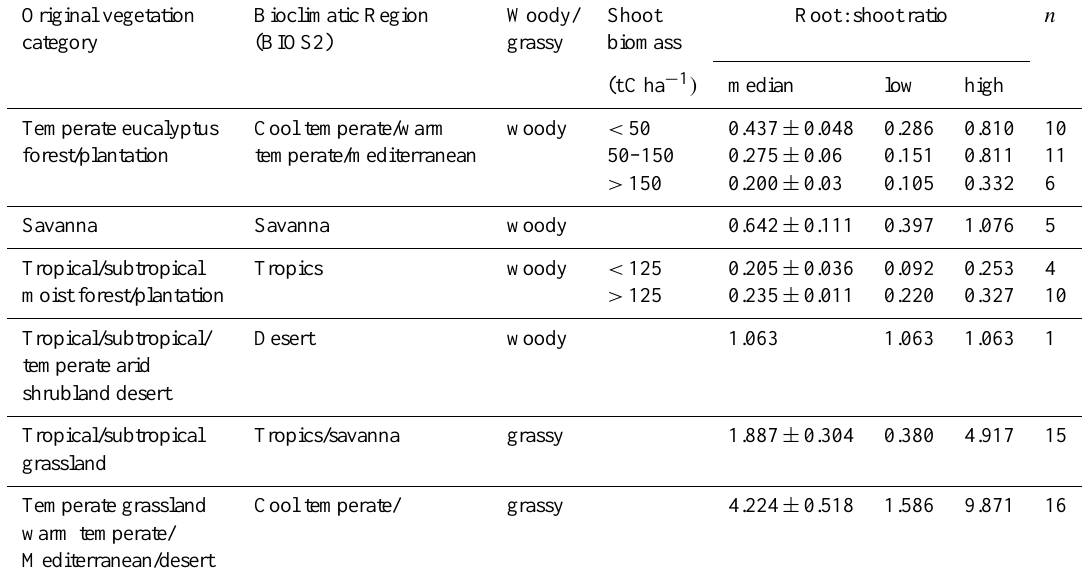
Table A4. Root:shoot ratios. Original vegetation Bioclimatic Region Woody/ Shoot Root:shoot ratio n category (BIOS2) grassy biomass